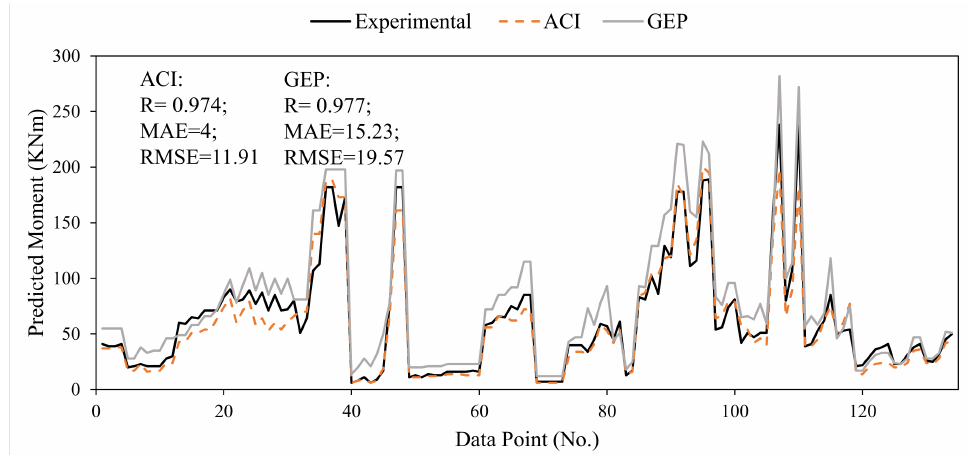
Figure 9. Comparison of ACI and existing AI